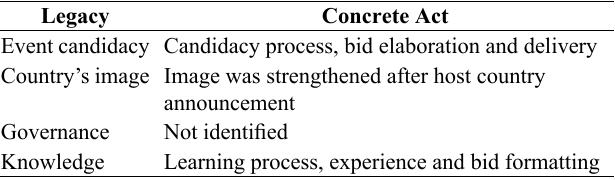
Table 6. Pre-event Legacy Legacy Concrete Act Event candidacy Candidacy process, bid elaboration and delivery Country’s image Image was strengthened after host